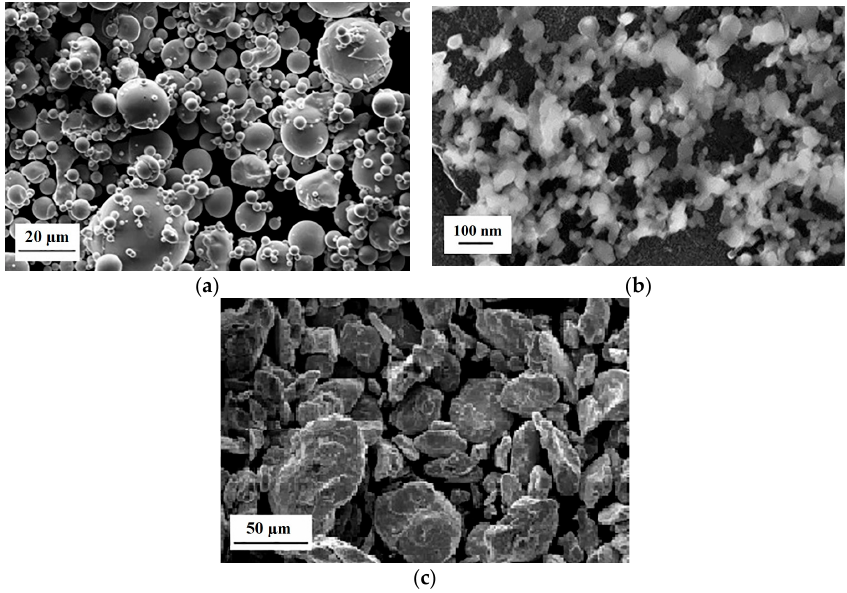
Figure 1. Powder of Fe-14Cr-1W-0.4Ti ferritic steel ( a ), Y 2 O 3 ( b ) and of the mixture after mechanical alloying (MA) ( c ).